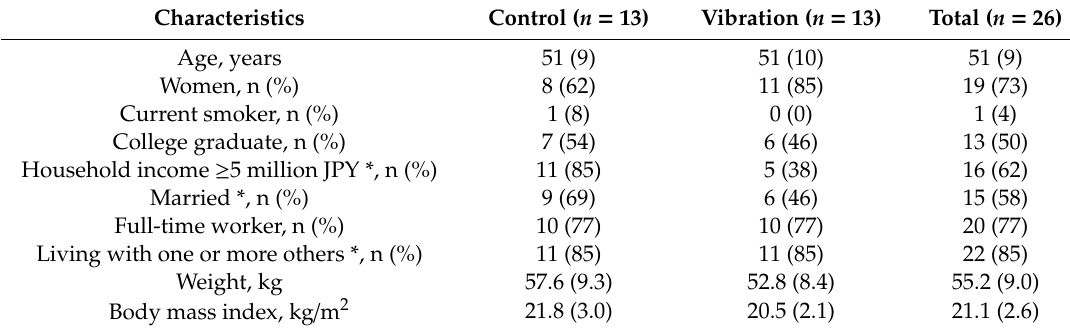
Table 1. Participant sociodemographic characteristics at baseline.